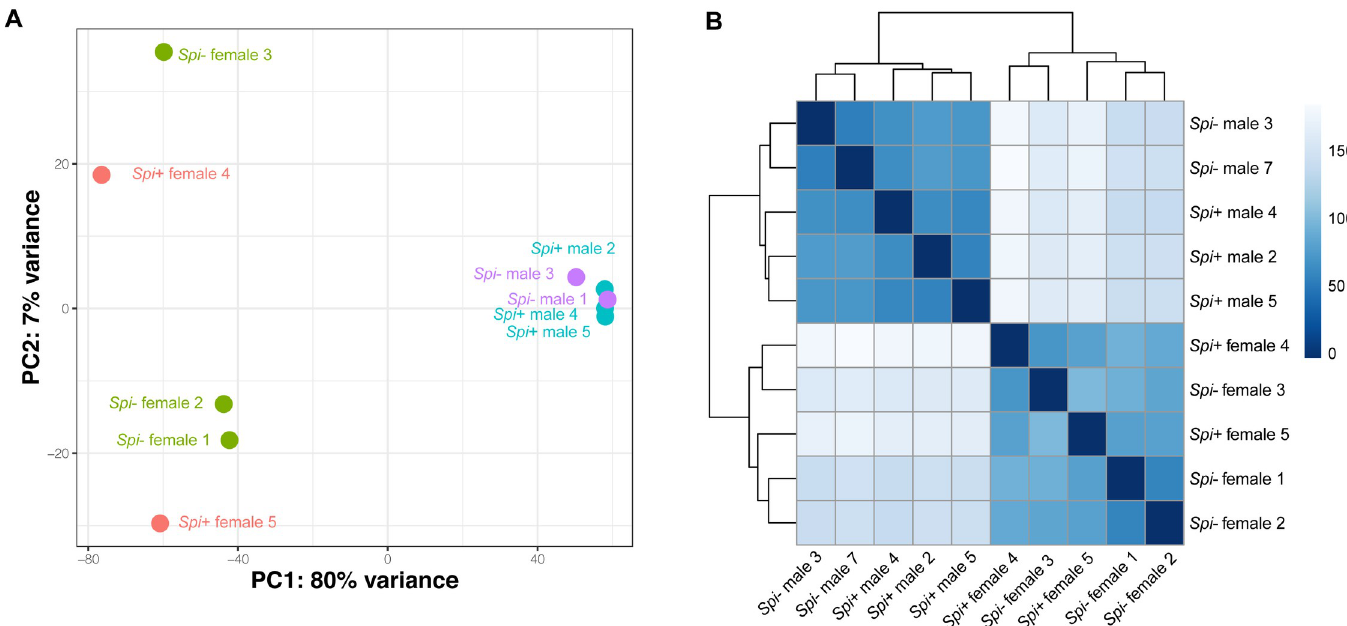
Fig 1. Principal component analysis (A) and Hierarchical clustering (B) of expression data. The Principal Component Analysis (PCA) is based on differentially expressed genes from the female and male samples, while the Hierarchical Clustering (HC) reflects all genes within the dataset. Spiroplasma -infection status and sex are color-coded in the